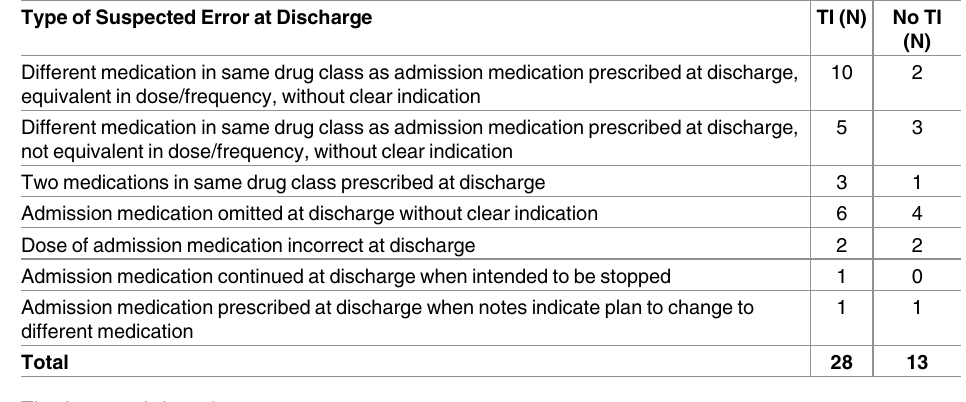
Table 3. Suspected medication reconciliation errors at discharge, characterized by